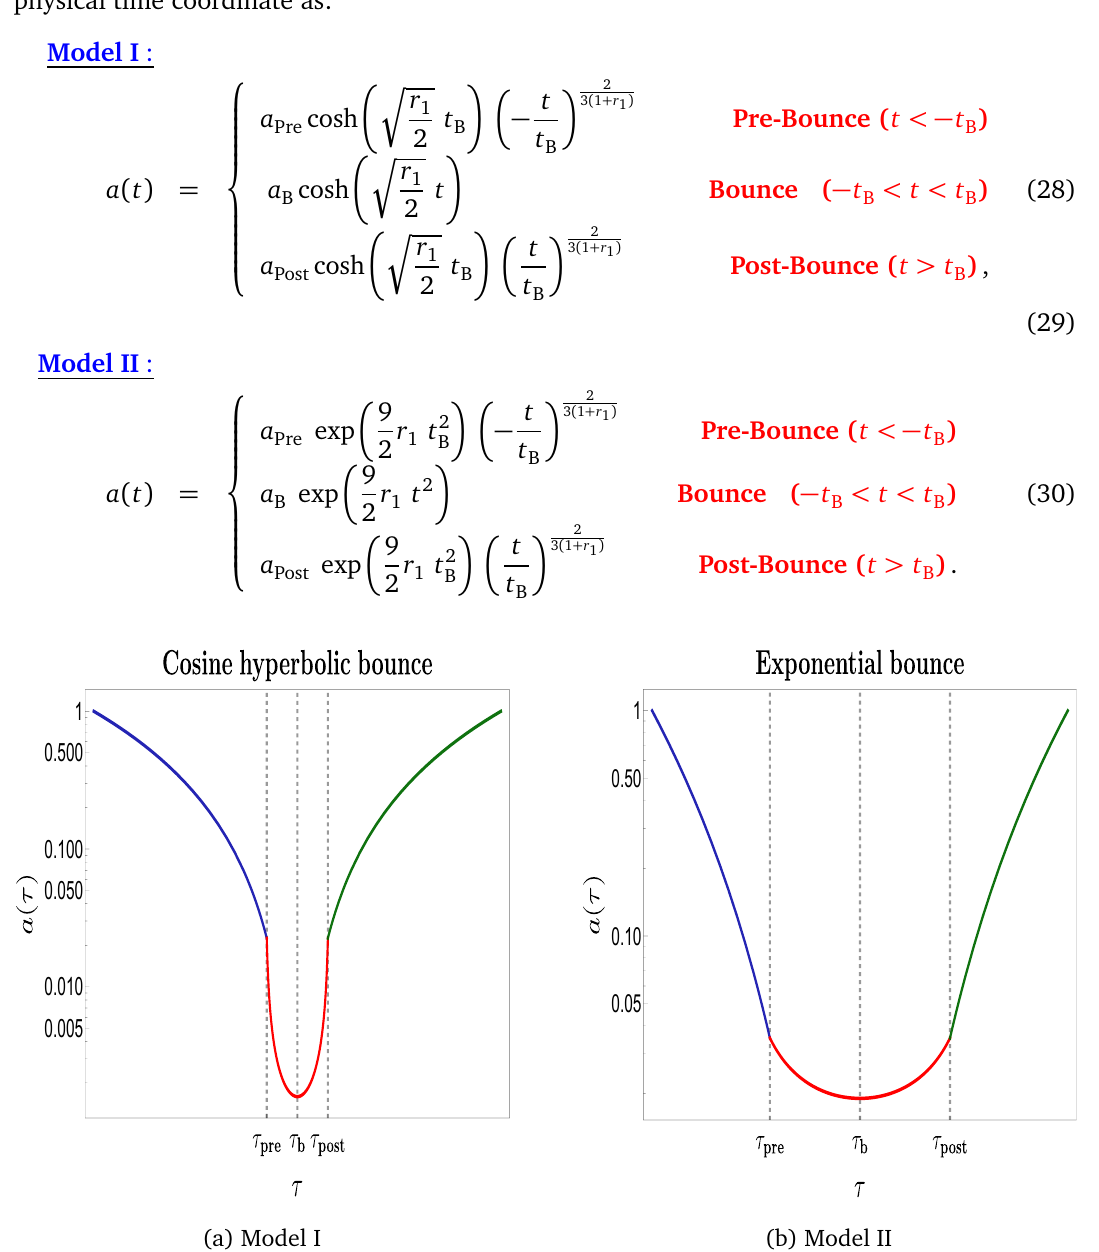
Figure 3: Variation of derivative of scale factor wrt the conformal time showing three different regions viz. Pre-bounce, Bouncing and the Post-bounce